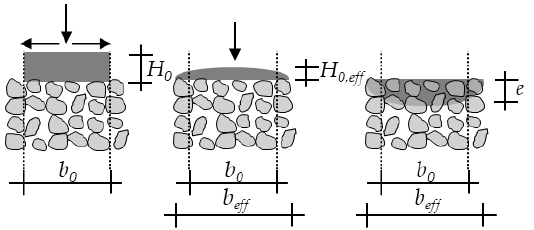
Figure 8. Spread characteristic of the cement paste; H 0 : Initial height of not penetrated cement paste; b 0 : Initial width of the not penetrated cement paste; b eff : width of the cement paste immedi- ately before penetration; H 0,eff : effective height of the cement paste, e: penetration depth. The applied cement paste strand with an initial height H 0 (m) and width b 0 (m) will spread aside to a width b eff (m) and a related effective height H 0,eff (m) which determines the effective hydrostatic pressure as driving force for the penetration. l nz